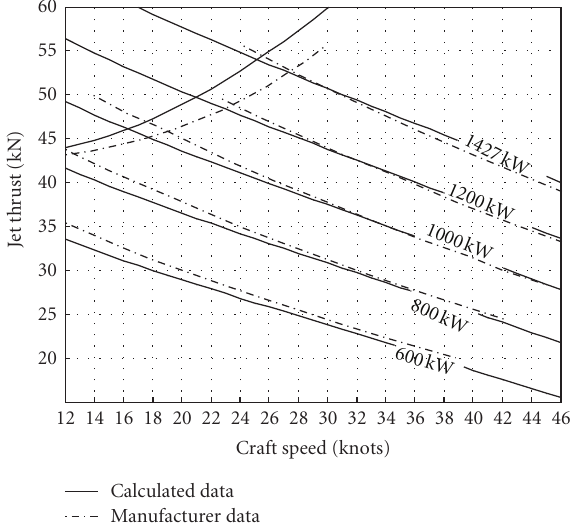
Figure 18: Thrust curves comparison with Hamilton Jet data.